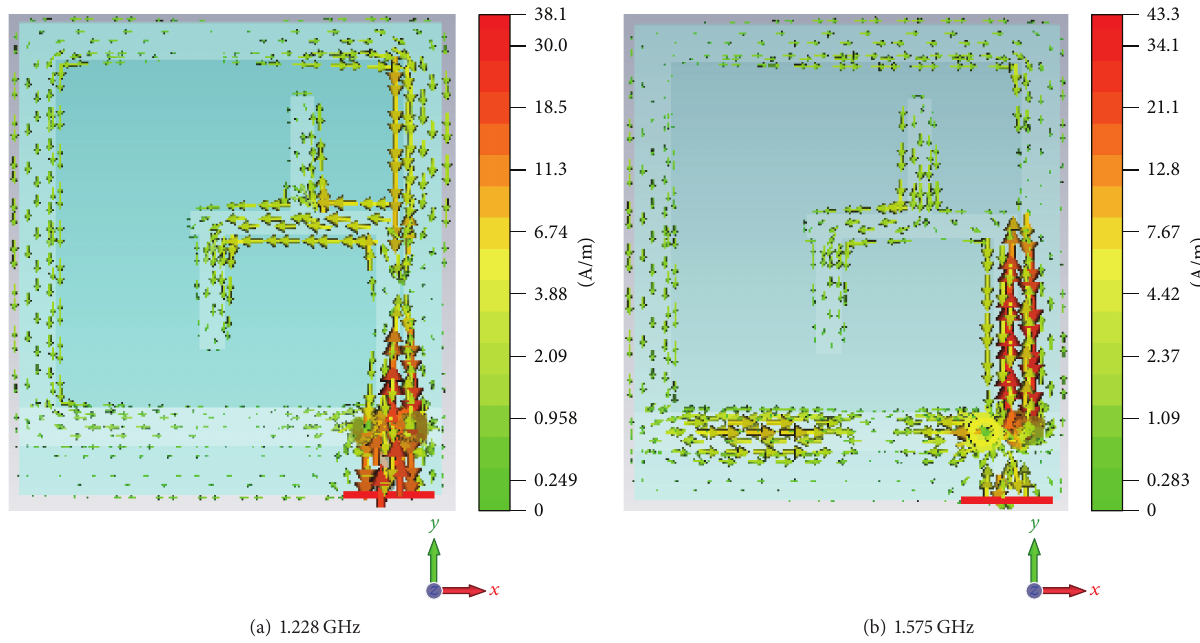
Figure 4: Simulated results of surface